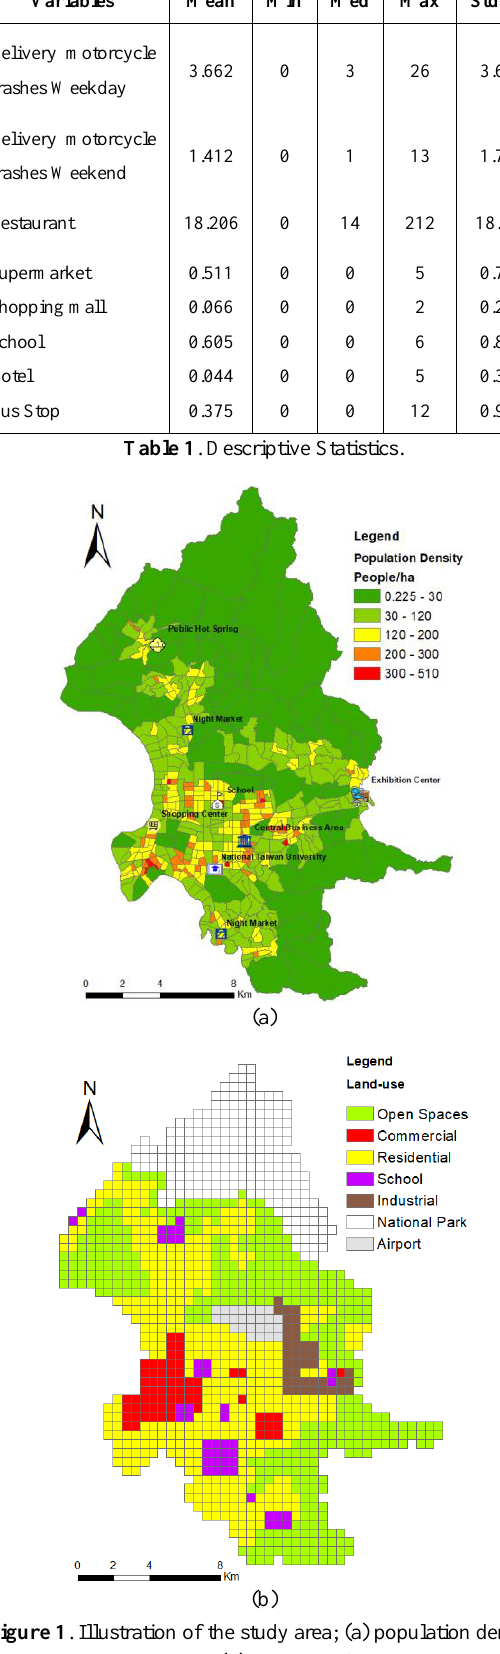
Figure 1 . Illustration of the study area; (a) population density distribution; and (b) land use of Taipei